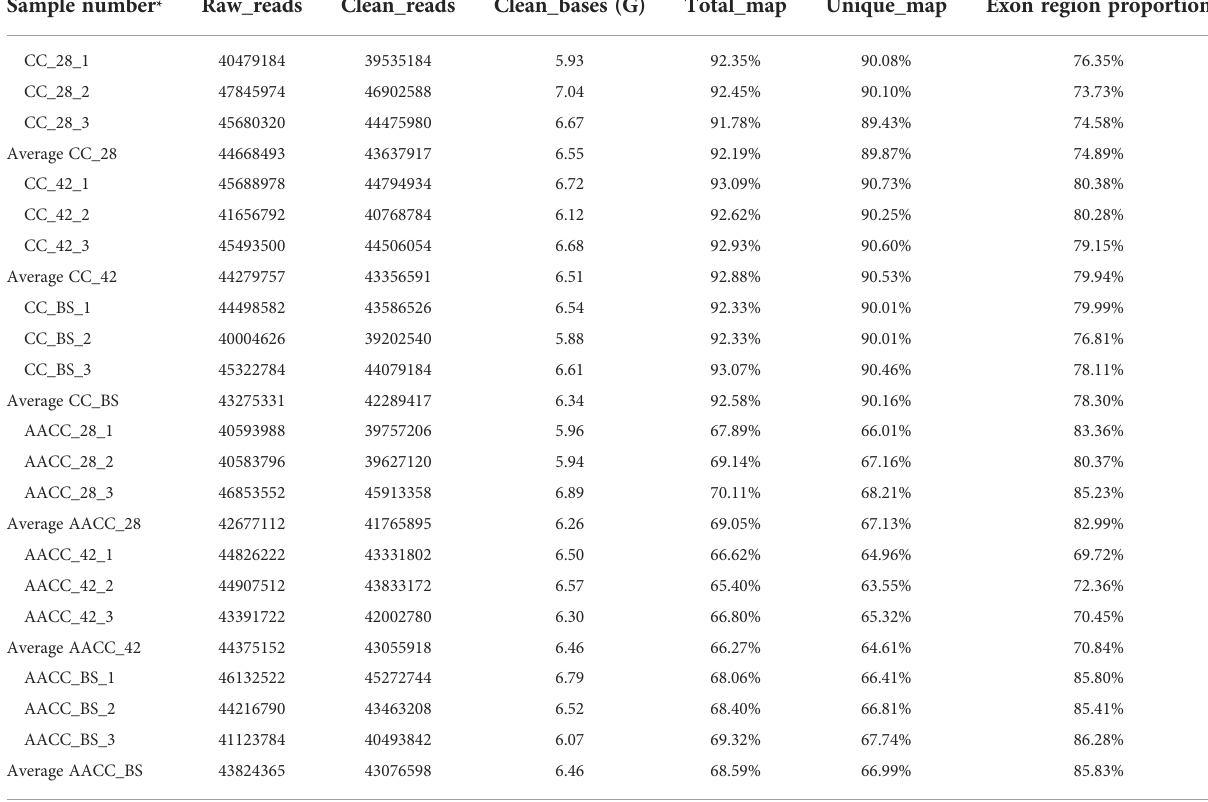
TABLE 1 Output quality of stem transcriptome sequencing data at three stages in Chinese kale (CC) and its allotetraploid